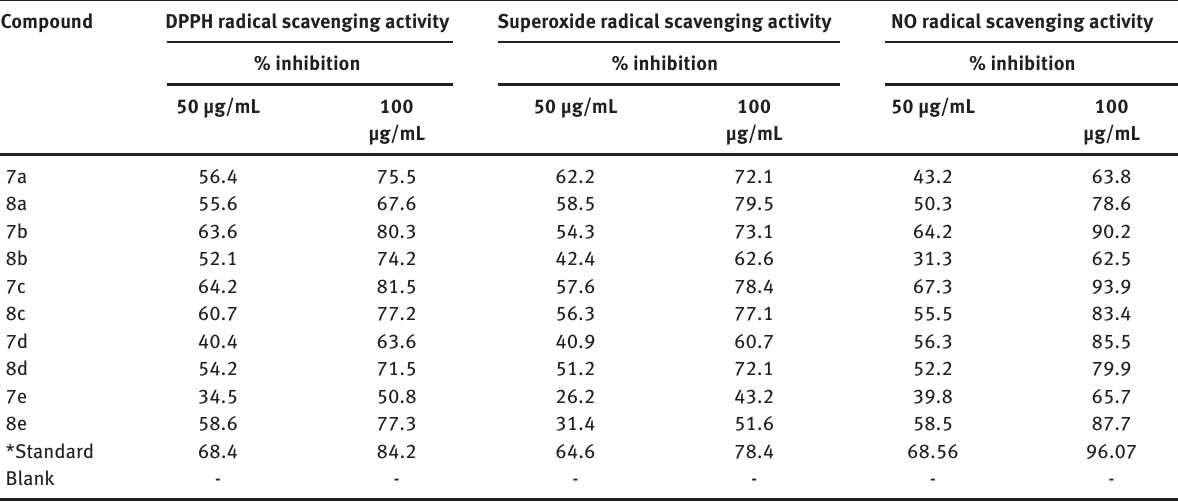
Table 2 : DPPH, superoxide and NO radical scavenging activities of compounds 7a - e and 8a - e .